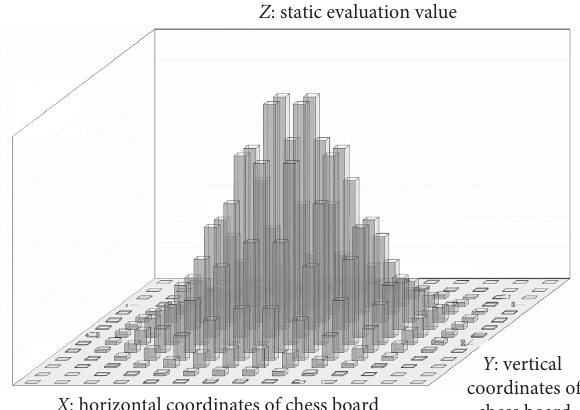
Figure 3: Approximate 2D normal distribution